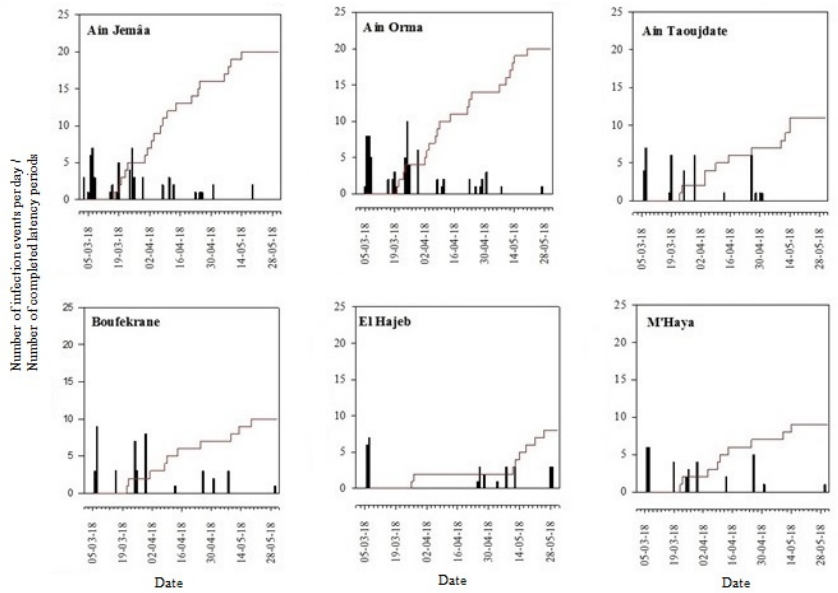
success index. Perfect score = 1.